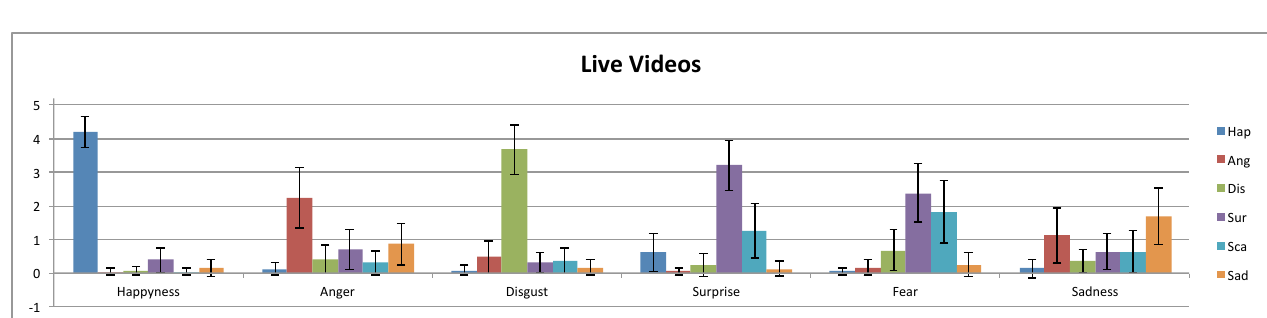
Figure 9. Rating obtained for the live videos (subjects) for each expression.